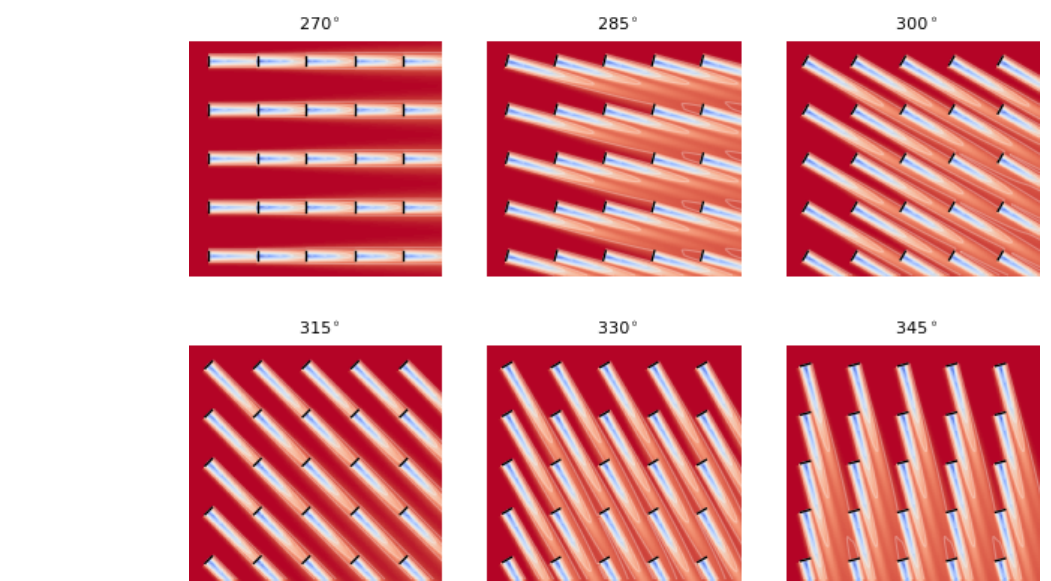
Figure 5. The flow field for a 5-by-5 square grid wind plant for different wind directions.